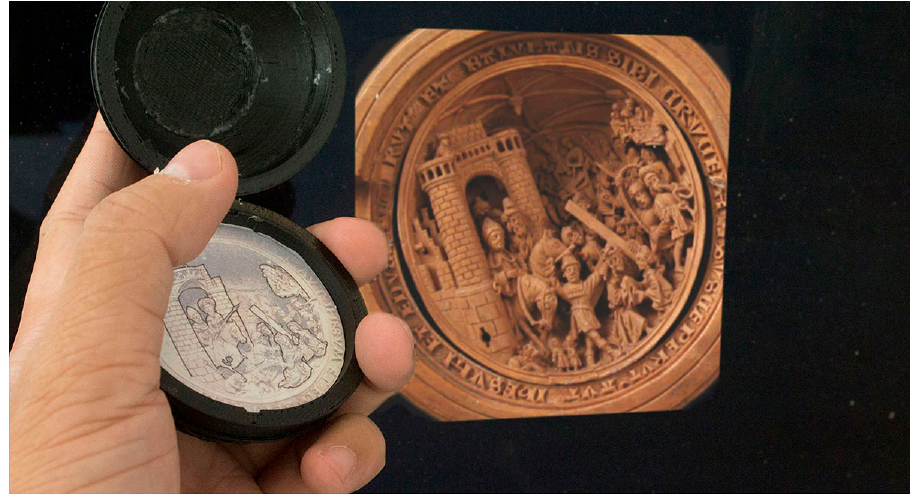
Figure 9. Visual Voyage F igure 9. Visual Voyage interaction.